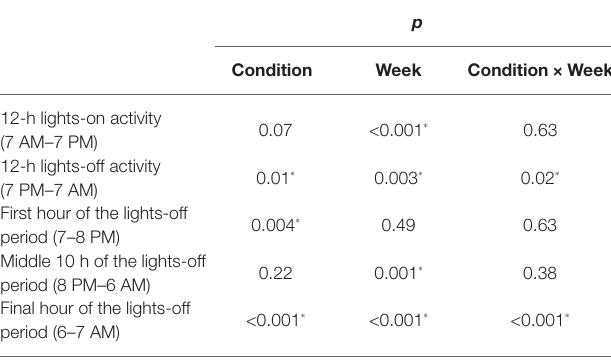
TABLE 2 | Results from linear mixed model analysis of the activity data for the factors condition and week, and the interaction of condition by week.